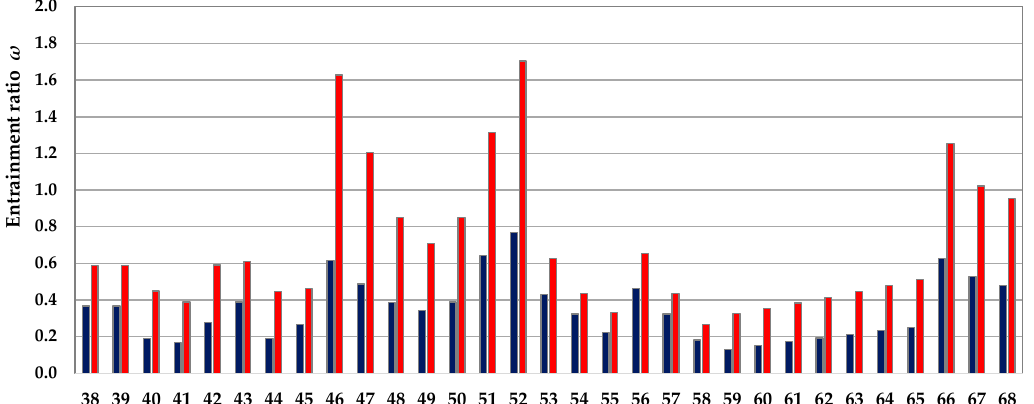
Figure 9. Industrial entrainment ratios ω ind vs. experimental ones ω exp for the first series of benchmark ejectors (Table 5).